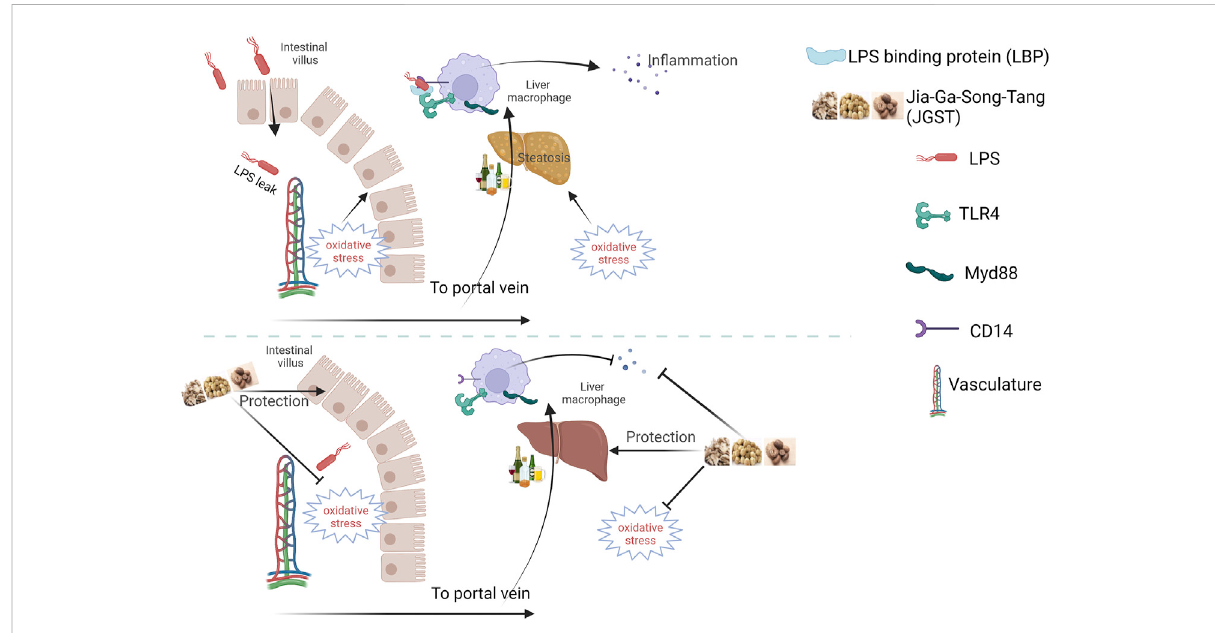
FIGURE 9 Schematic diagram of Jia-Ga-Song-Tang protection against alcoholic liver and intestinal damage. It was created in the website www.